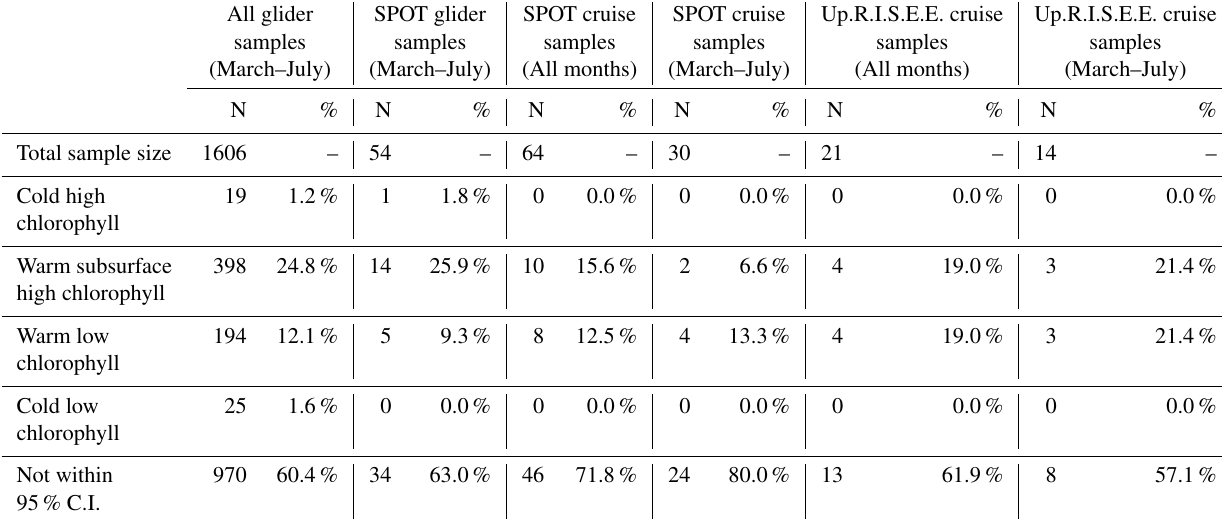
Table 1. Distribution of profile types as estimated by the structured PCA. The number of profiles that fall within each end-member group (95% confidence interval) is given (N, %) for all glider profiles (all glider), glider profiles from the SPOT bin (SPOT glider), all ship-based SPOT profiles (SPOT cruise), ship-based SPOT profiles from the months that the gliders were in the water (SPOT cruise March–July), all Up.R.I.S.E.E. ship-based profiles (Up.R.I.S.E.E. cruise), and Up.R.I.S.E.E. profiles from the months that the gliders were in the